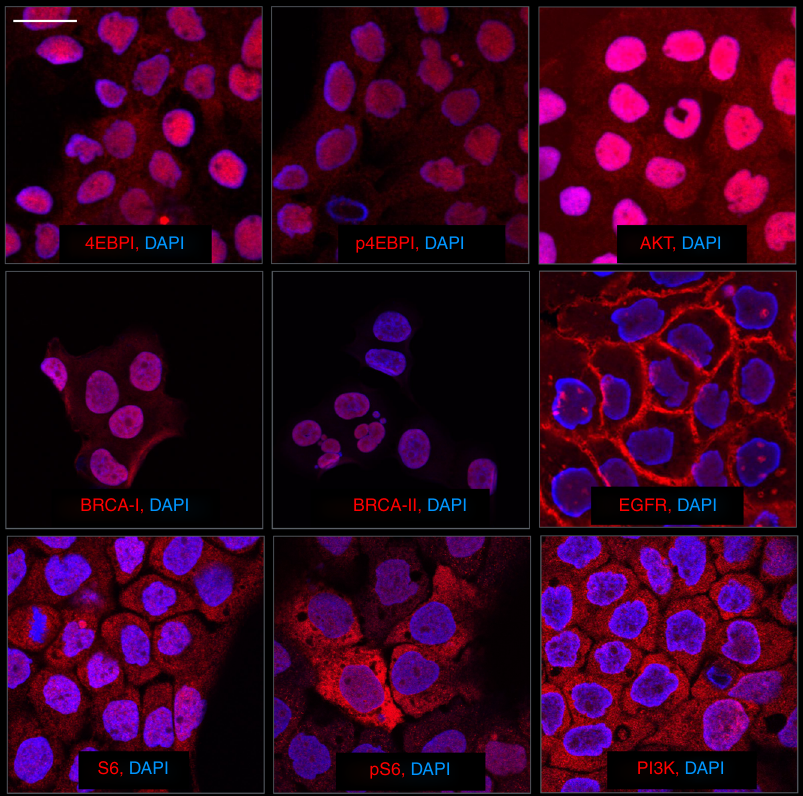
Fig. 3 Staining of different cellular targets of interest. Representative examples of cultured A431 cells stained with DAPI to highlight nuclei. Different mAb – DNA conjugates were used to reveal primary targets shown. Scale bar (top left) represents 30 µ m